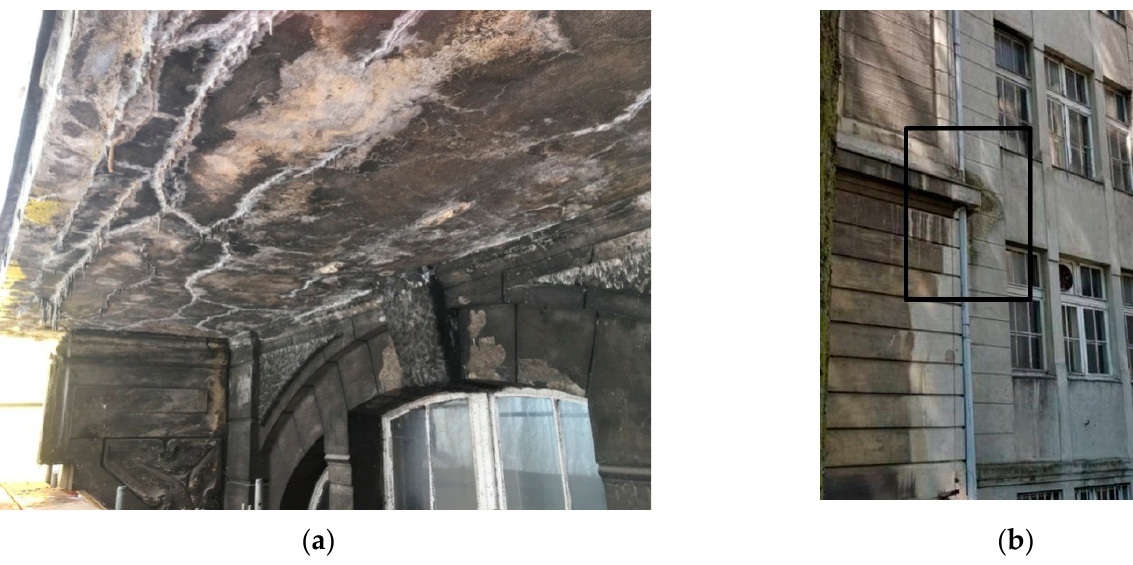
Figure 6. Dampness of the balcony ( a ) and the building walls ( b ). Corrosion of the reinforced concrete structure is visible on the eastern and southern facades. The layer around the reinforcement has been destroyed there, and the corroded rebar is visible (Figure 7).